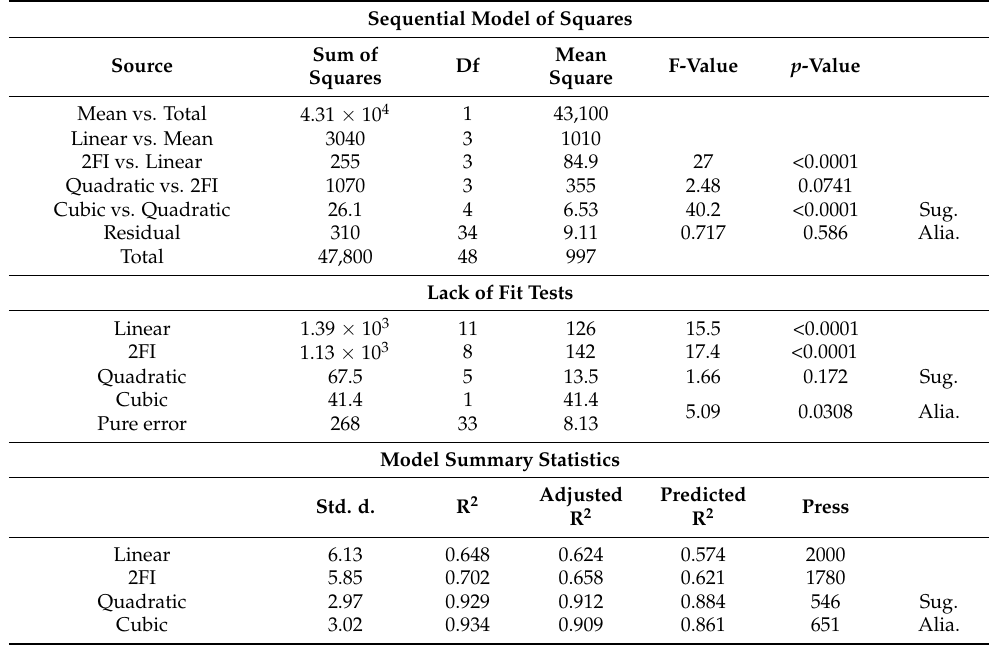
Table 3. Sequential model fitting for tensile index.